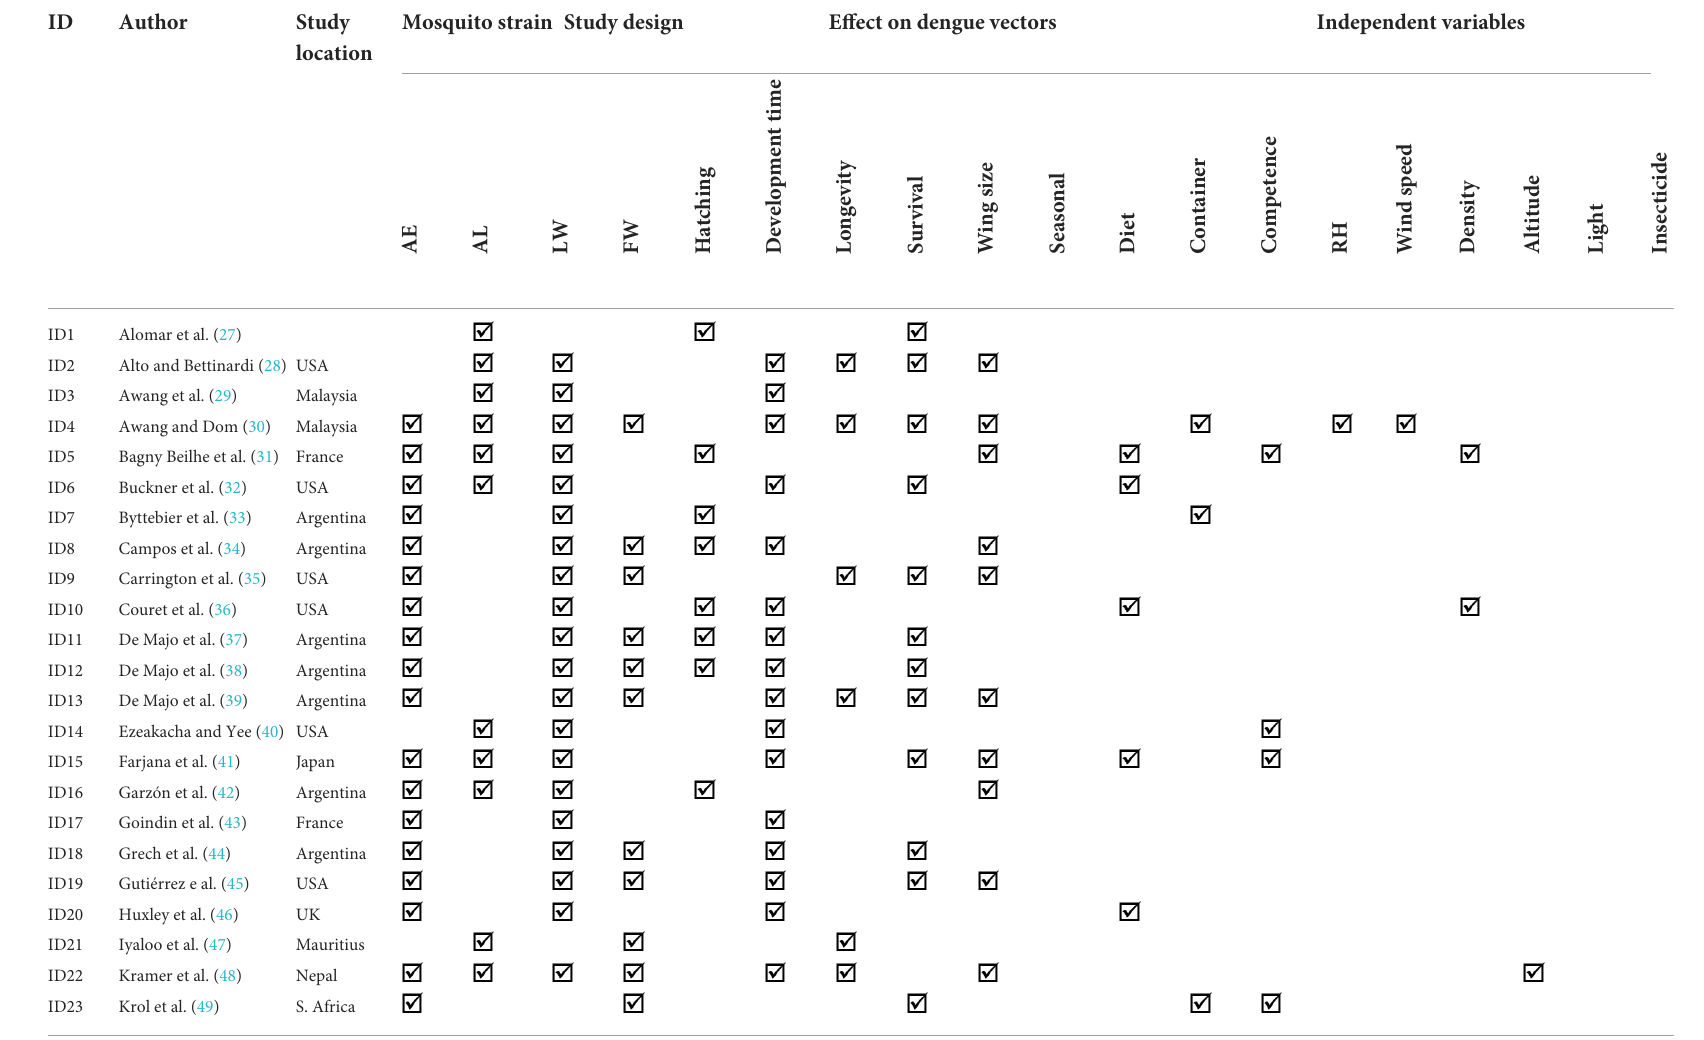
TABLE 1 Summary of the articles related to effect of temperature on Aedes